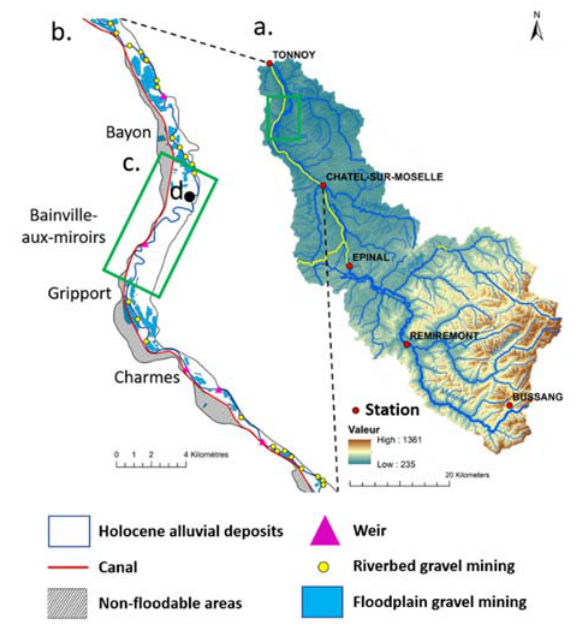
Figure 1: Study site